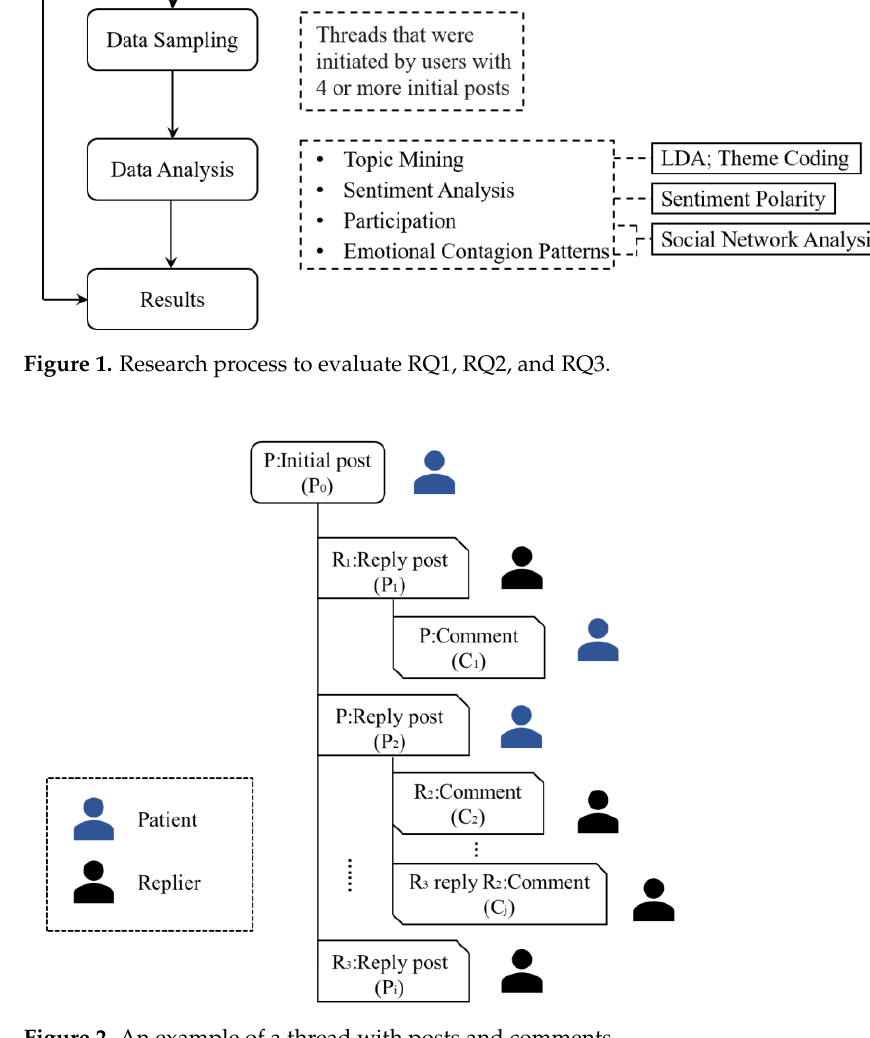
Figure 2. An example of a thread with posts and comments.